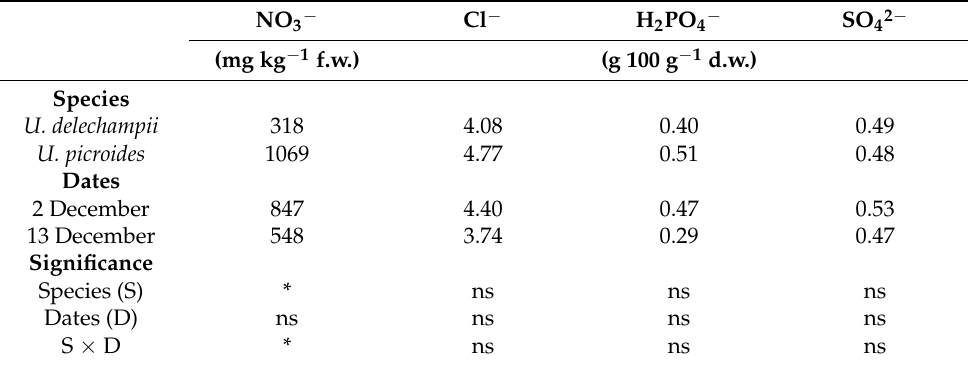
Table 6. Anion content of wild smooth golden fleece ( U. delechampii ) and wild prickly golden fleece ( U. picroides ) gathered in grasslands on different